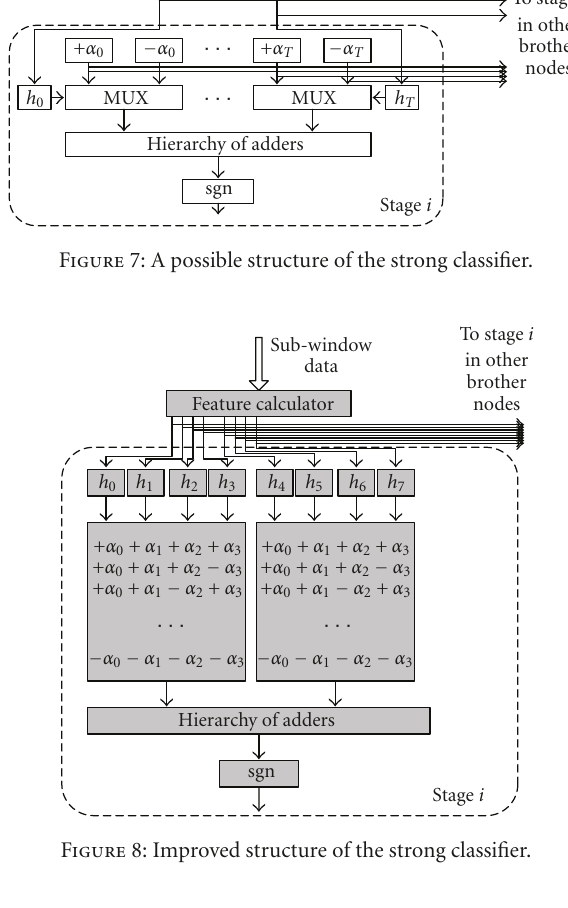
of h (cid:6)(cid:6) for further hyper-rectangle-based decision. Figure 9 t shows the dataflow.